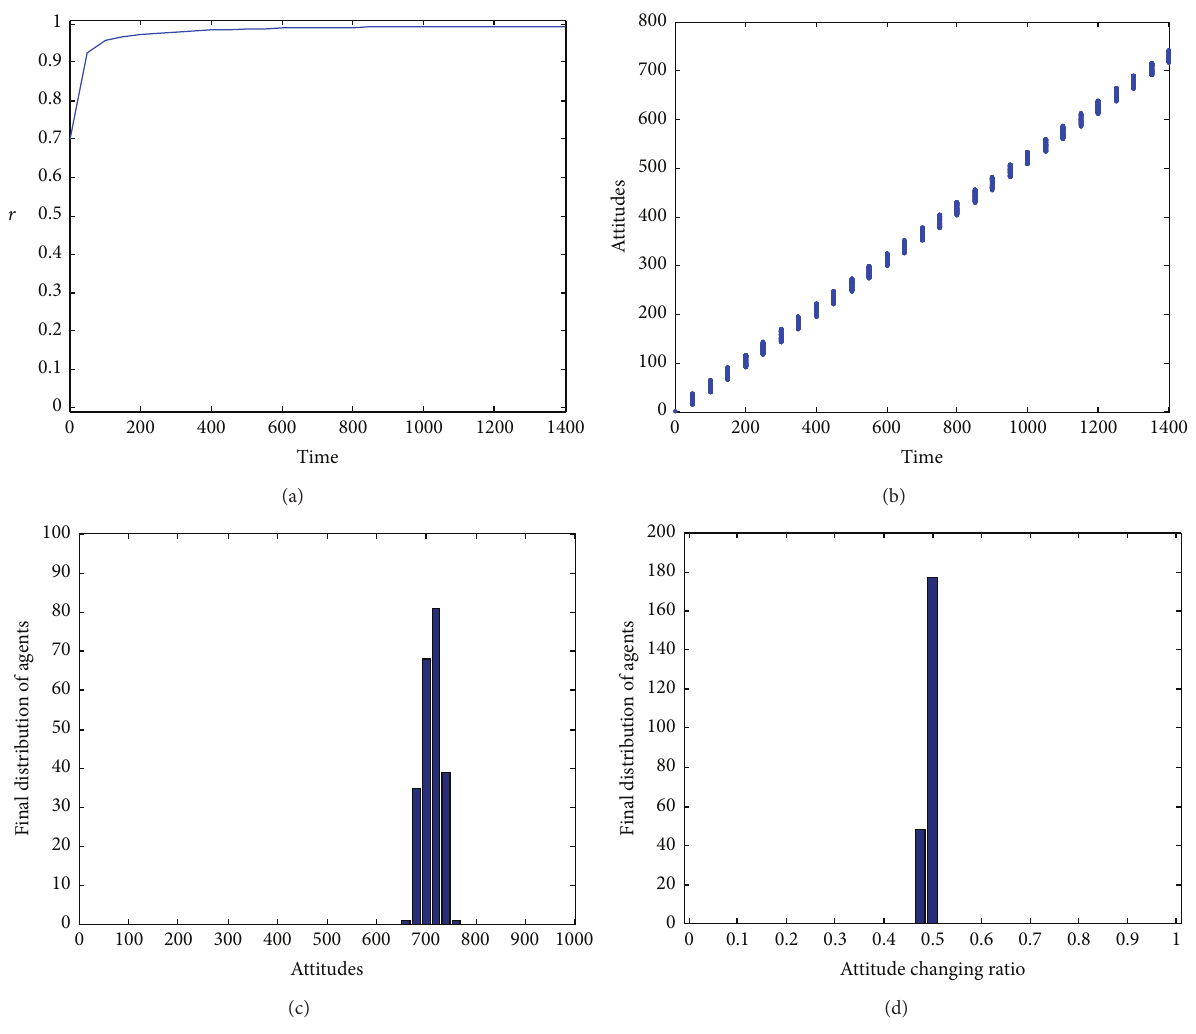
Figure 4: Results of simulation system with 𝐾 = 2 . (a) is the subfigure which shows synchronization criterion 𝑟 changes with time; (b) is the subfigure which shows group attitudes 𝑥(𝑡) versus time; (c) is the histogram of the final distribution of agents versus group attitudes 𝑥(𝑡) ; (d) is the histogram of the final distribution of agents versus attitude changing ratio ̇𝑥 𝑖 (𝑡)